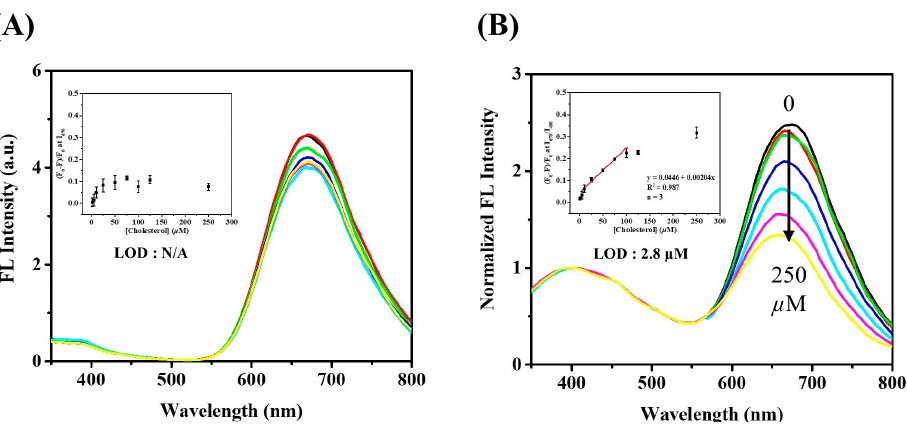
Figure 5. Fluorescence emission spectra of ( A ) GSH/BSA-AuNCs and ( B ) GSH/BSA-AuNCs@VCDs in aqueous solution upon addition of various concentrations of cholesterol (from top to bottom: 0, 1, 5, 25, 50, 125, 250 μ M), excitation at 320 nm. Insert: Stern–Volmer plot.